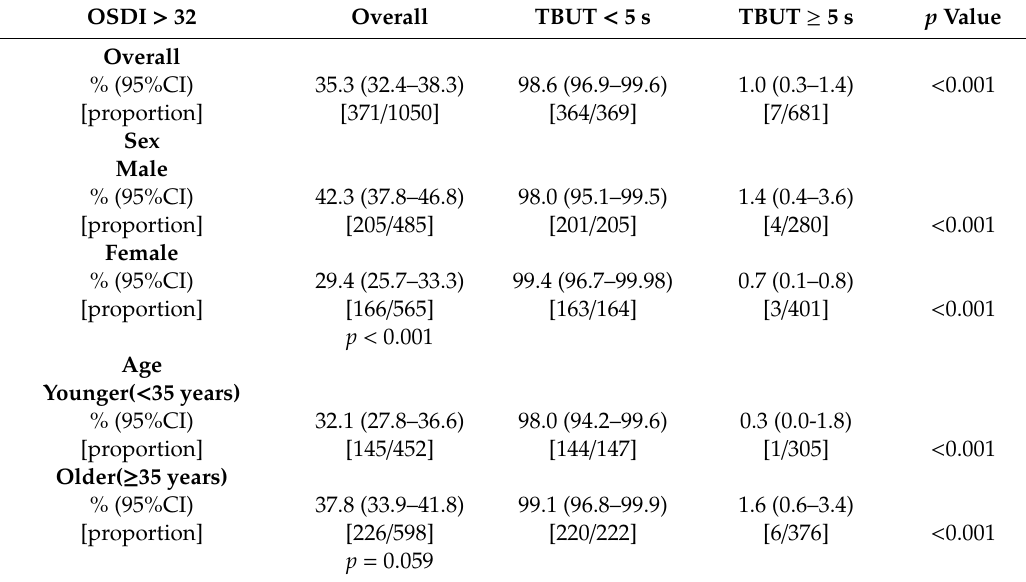
Table 5. Relationship of severe dry eye symptoms and tear breakup times (TBUT) in factory